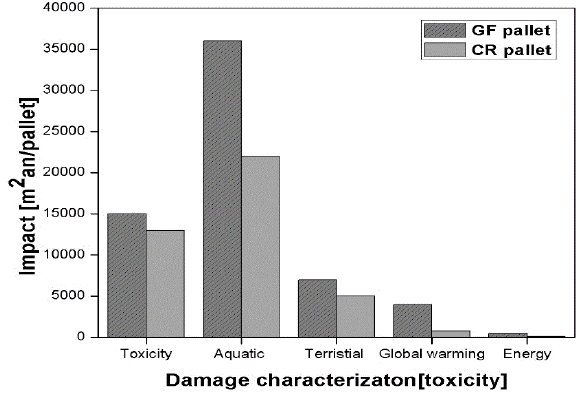
Figure 4. Critical surface time study for damage characterization of glass fibre (GF) and China reed (CR) pallet. Reprinted with permission from Reference [21]. Copyright 2001, with permission from Elsevier.